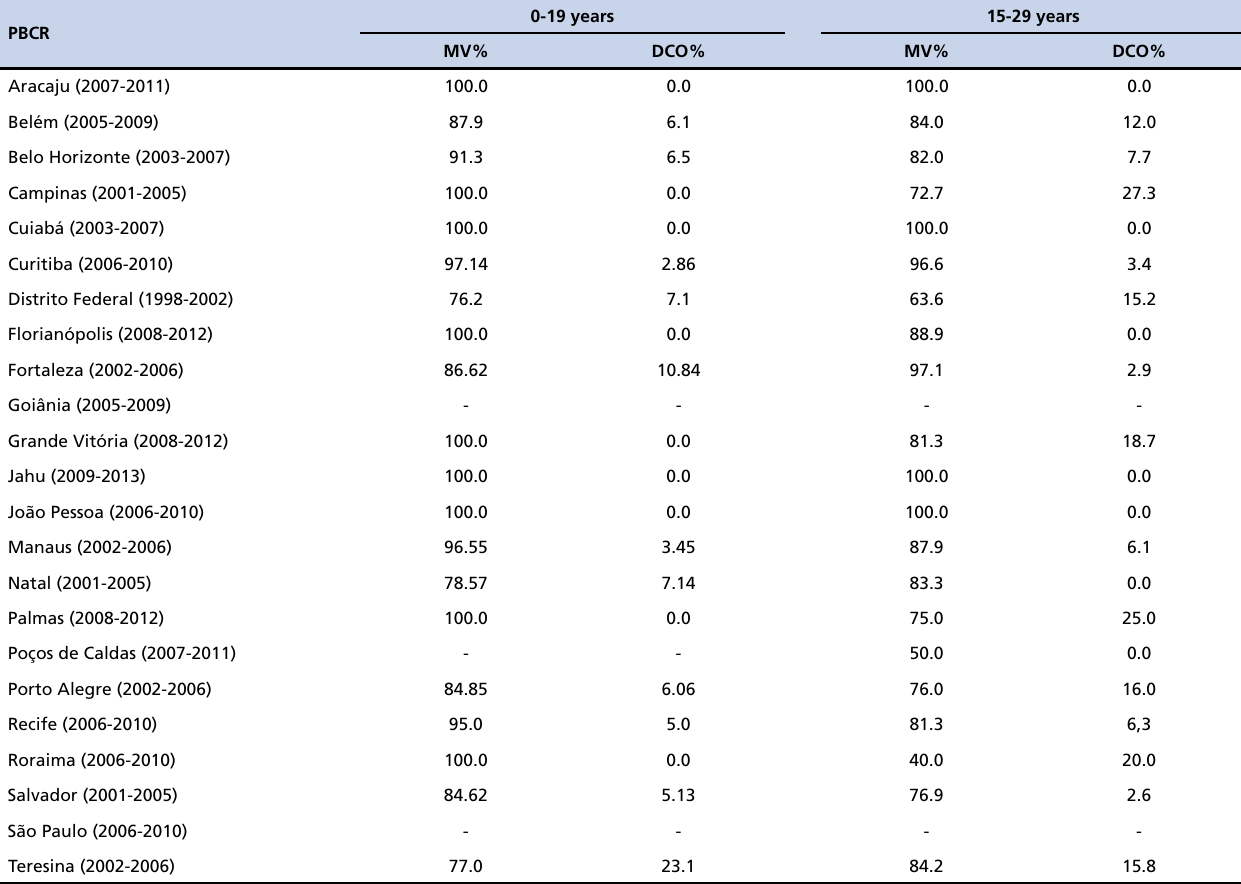
Supplemental Table S1 - Data quality indicators of 23 Brazilian PBCR and your respective periods of information, according to International Agency for Research in Cancer